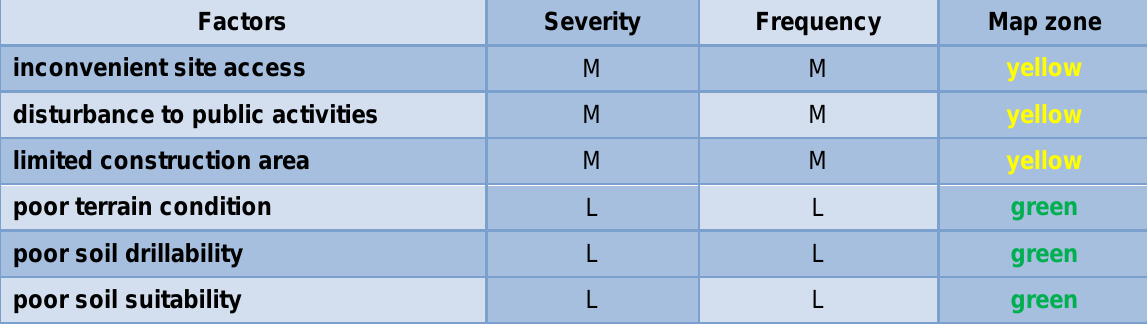
Table 2 Risk map for factor under project group